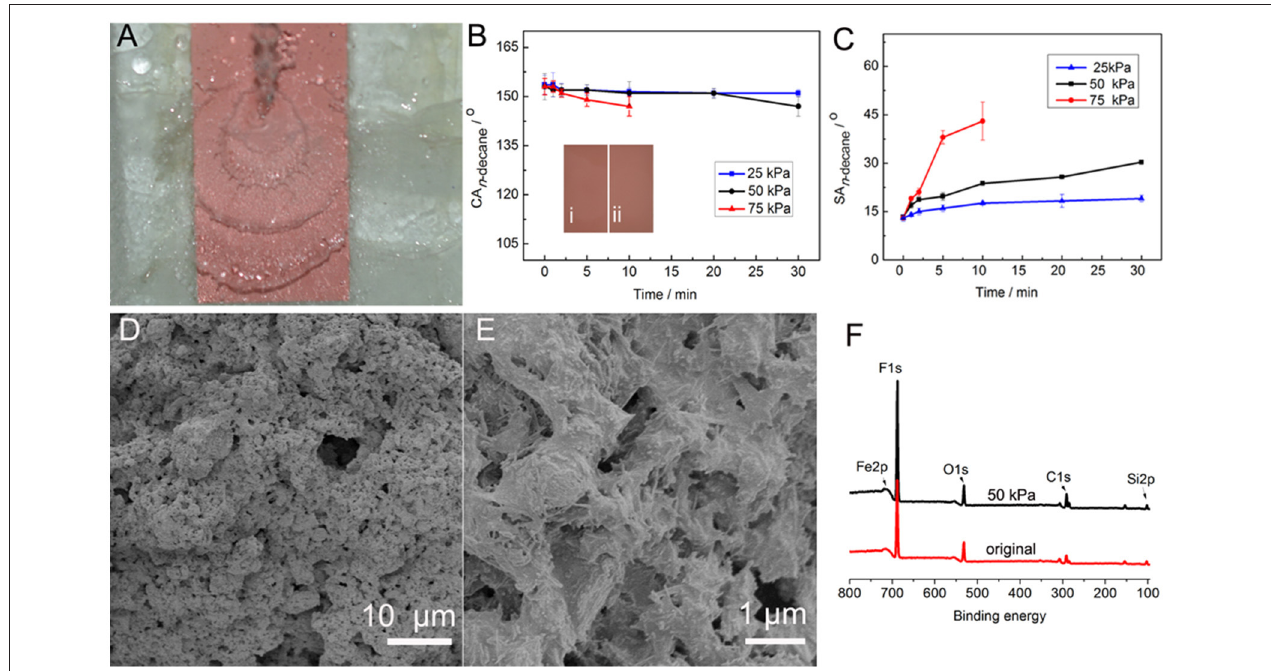
FIGURE 7 | (A) Water jetting test at 50 kPa, and variation of (B) CA n − decane and (C) SA n − decane of the PAL/IOR@fluoroPOS coating with water jetting pressure and water jetting time. (D,E) SEM images and (F) XPS spectra of the coating after water jetting at 50 kPa for 30min with the original coating for comparison. The insets in (B) are (I) the original coating and (II) the coating after water jetting at 50 kPa for 30min. C PAL / IOR = 14g L − 1 , t grinding = 20min, C PFDTES = 27.2mM, C TEOS = 4.5mM.